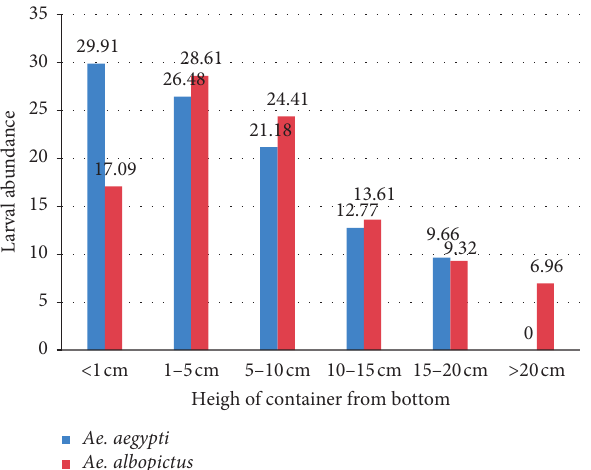
Figure 6: Relative abundance of Aedes spp. larvae in containers with different heights.